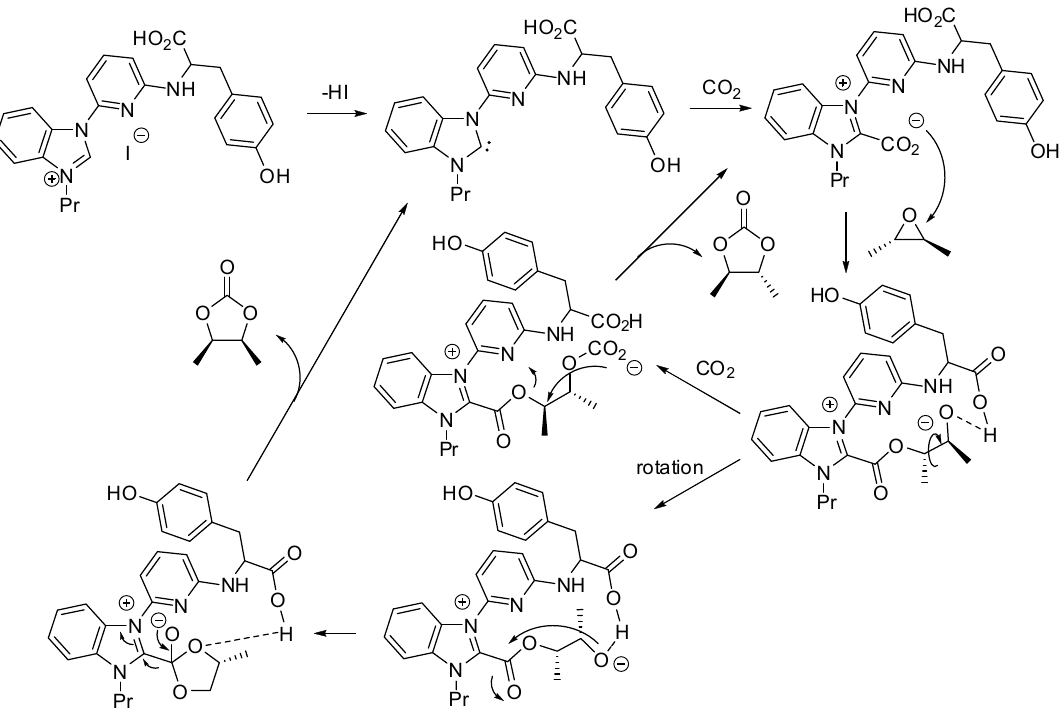
Scheme 3. Mechanism proposed for cooperative multifunctional organocatalysts.